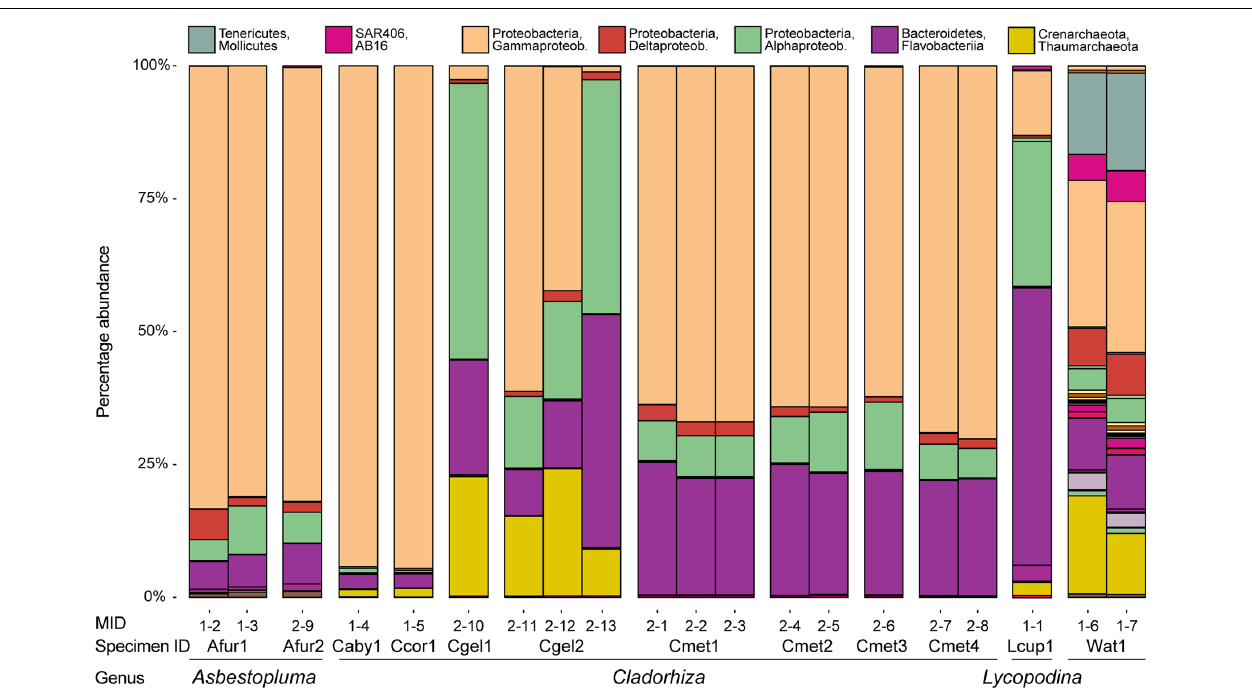
FIGURE 5 | Microbial abundance for individual samples (MIDs) at the class level for the purposes of assessing similarity between individual samples for the same species. Also indicated is specimen ID and genus assignment. Samples from the same specimen were pooled in subsequent analyses.